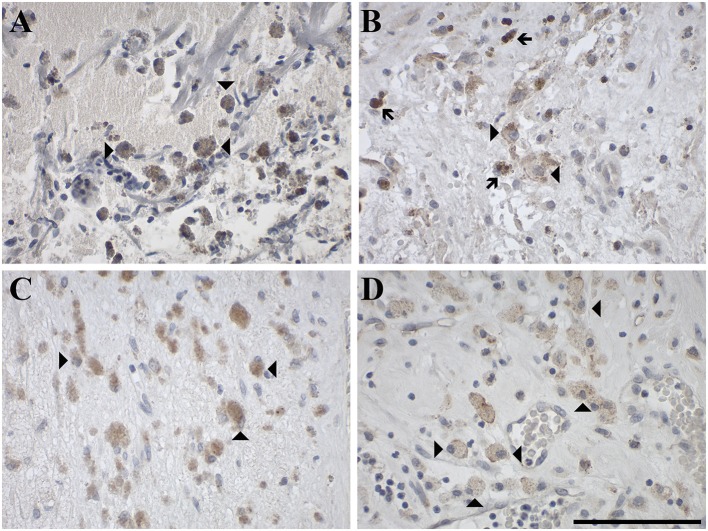
Representative images of immunohistochemical staining of GAMs stained positive for (A) GAL in an oligodendroglioma (WHO grade II; case 51), (B) GAL1-R in an anaplastic oligoastrocytoma, NOS III (case 54), (C) GAL2-R in an anaplastic oligoastrocytoma, NOS III (case 54) and (D) GAL3-R in a gliosarcoma (WHO grade IV; case 25). Arrow heads indicate positive-stained GAMs and arrows indicate hemosiderophages, which contain brown granules due to hemosiderin. [scale bar: 100 μm].